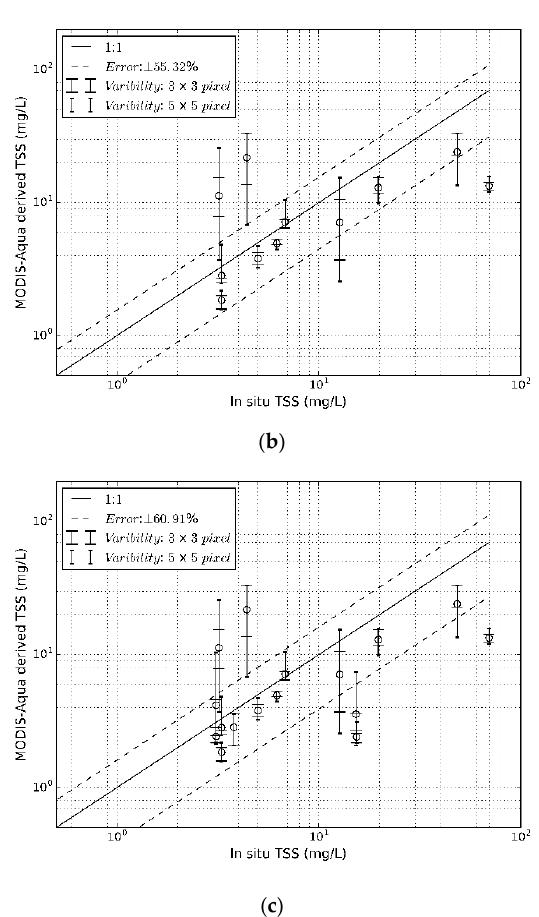
Figure 7. Validation between the SASM-derived TSS from MODIS-Aqua band 1 reflectance for ( a ) AVD30; ( b ) AVD60; and ( c ) AVD90. The error bar indicates the minimum and maximum TSS computed in 3 × 3 and 5 × 5-pixel window widths.